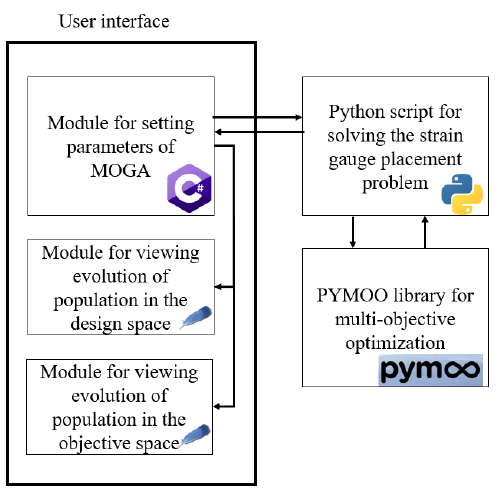
Fig. 1. Framework